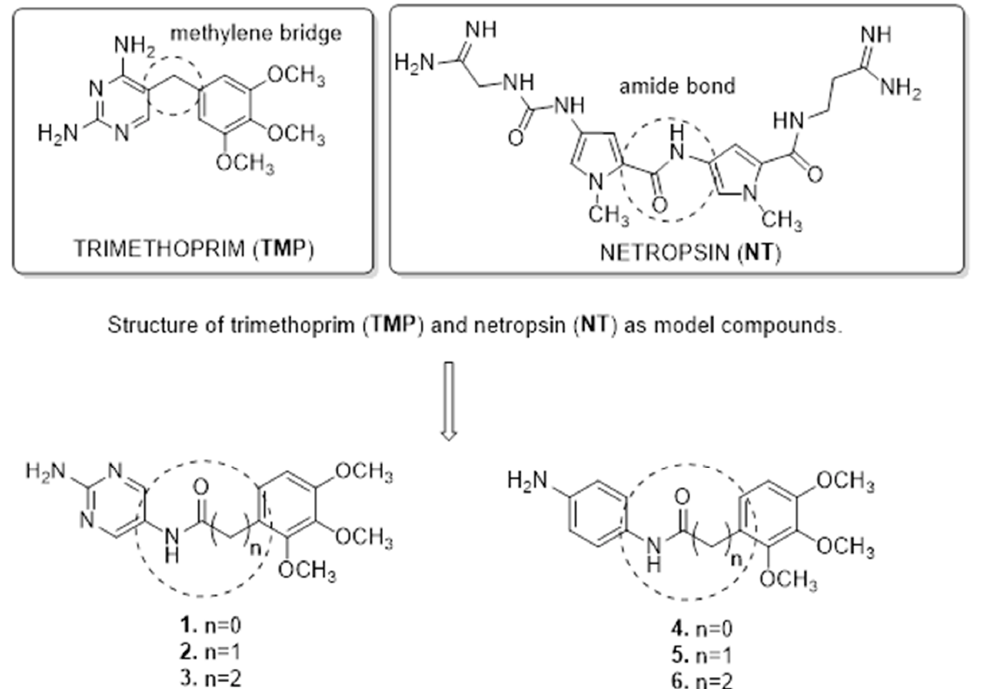
Figure 2. Combining structure features of TMP as template and amide moieties to synthesis of targeted compounds 1 – 6 .